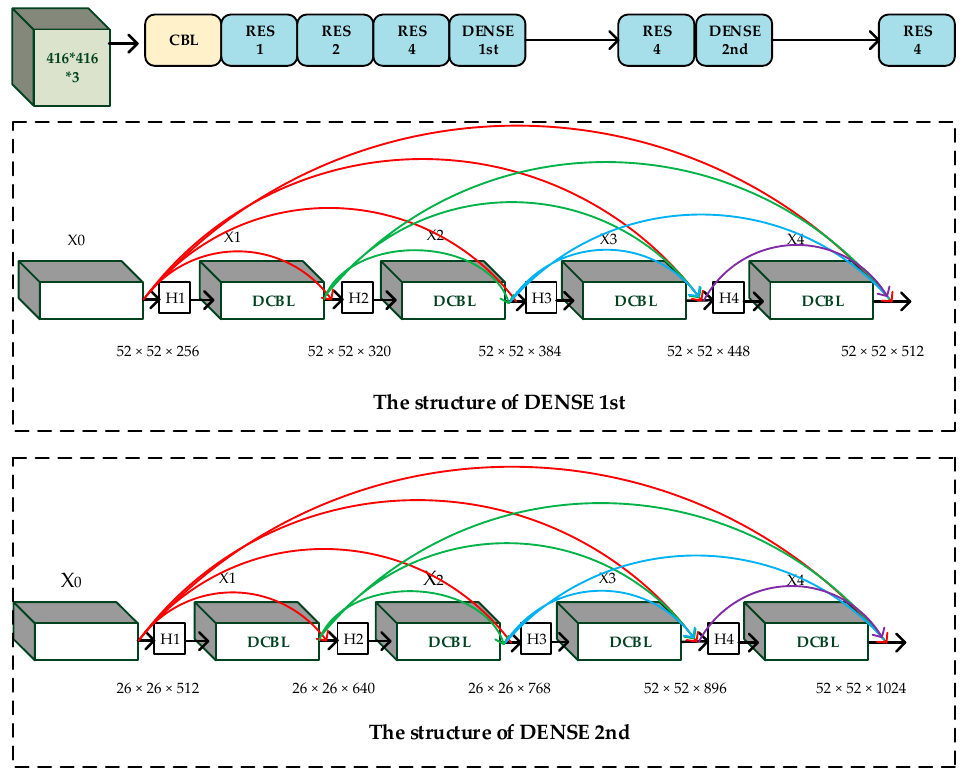
Figure 3. The structure diagram of the feature extraction network.